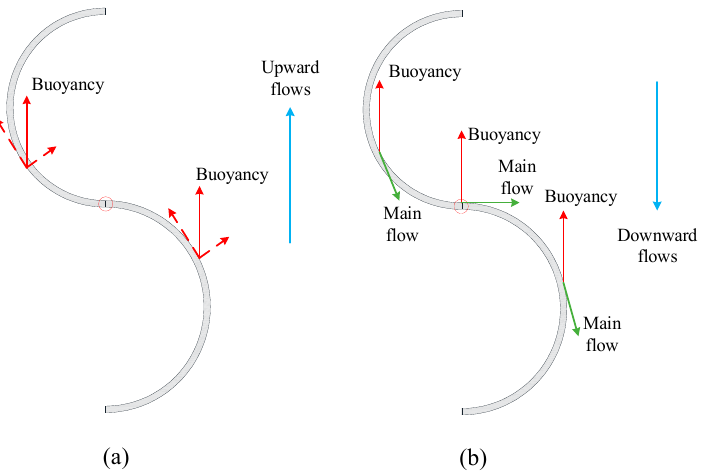
Figure 7. Schematic diagram of buoyancy effect on fluid flow in vertical serpentine tube [30]. ( a ) Upward flows (the buoyancy force or its component in the same direction as the main flow); ( b ) downward flows (the buoyancy force or its component in the opposite direction of the main flow).